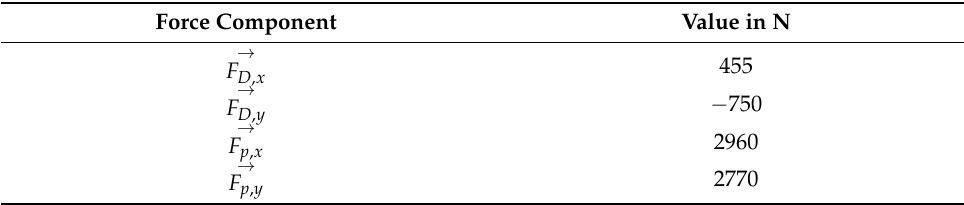
Figure 9. Initial design space of the rocker chosen for TO and AM with its related forces. Table 1. Force components for the chosen topology optimization (TO) problem. The values are based on the measurements of a formula student racecar